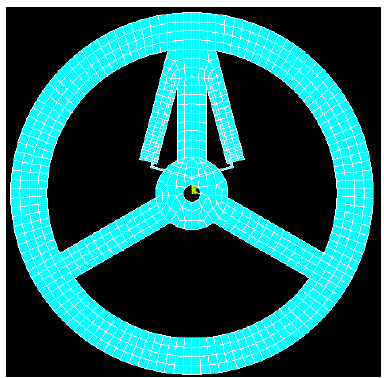
Figure 7. Mapped Mesh Model of the TSHS.